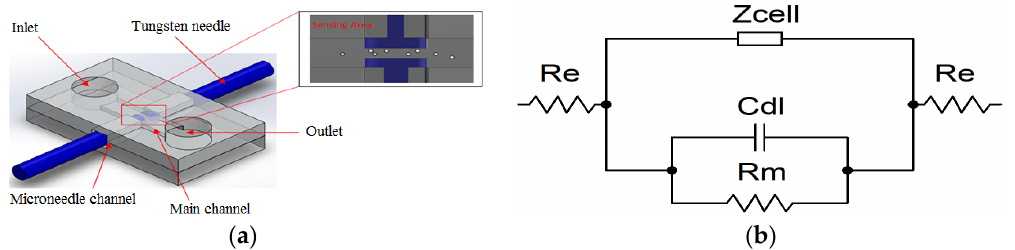
Figure 1. ( a ) 3D schematic diagram of the device structure and top view of sensing area; ( b ) An equivalent circuit model of sensing area of microfluidic chip. C dl : capacitance of double layer; R e : electrode resistance; R m : solution resistor; Z cell : cell impedance.